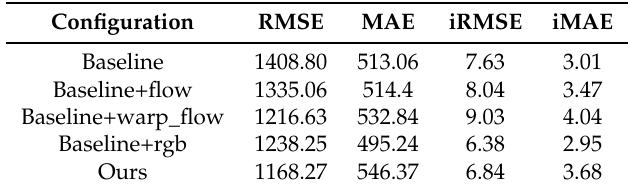
Table 1. Ablation study: performance achieved by our network with and without each module.